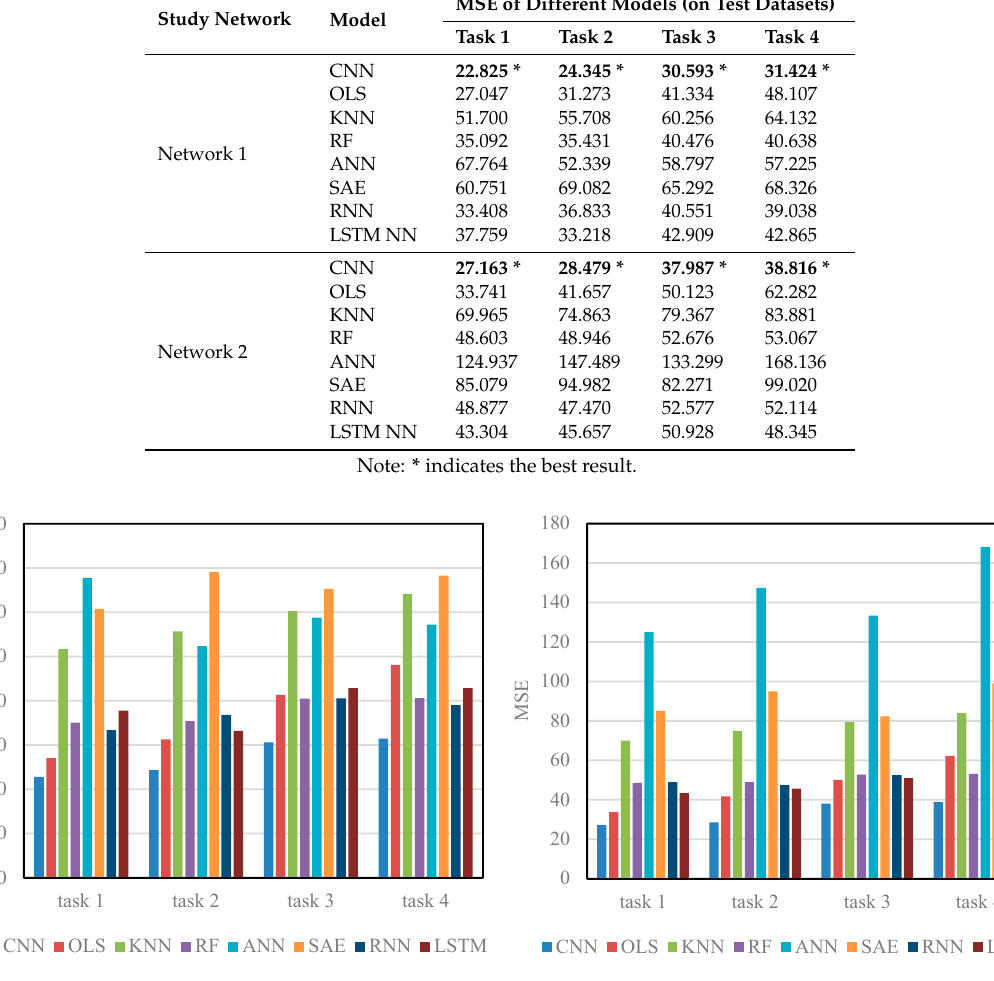
( b ) Figure 7. Training time of different algorithms: ( a ) training time on Network 1; and ( b ) training time on Network 2. Based on the above discussion, useful conclusions can be yielded as follows: 